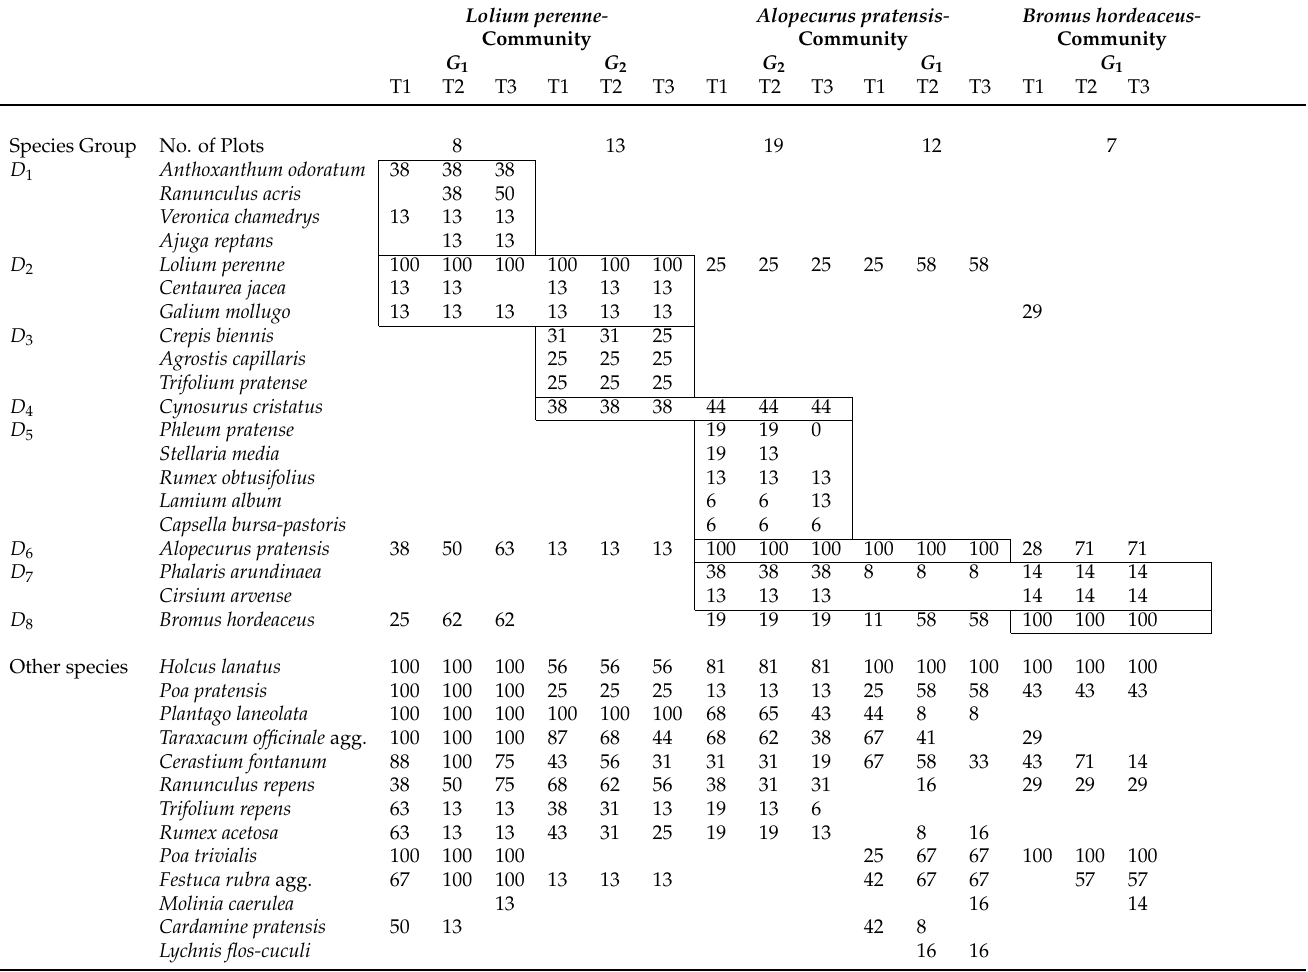
Table A1. Frequency values (in %) of species in the plant communities of Lolium perenne , Alopecurus pratensis , and Bromus hordeaceus . Identified species groups indicating plant communities are marked. Other species include common Arrhenatheretalia species not differentiating between vegetation types. Note the changed order of the growths of the Alopecurus pratensis community for better visualization.